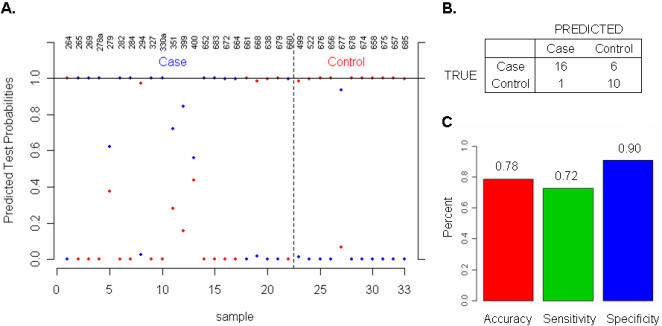
Validation of the 41-gene classification model using microarray analysis on an independent set of testing samples.(A). Classification probabilities for each testing sample: TAA (case) vs. normal (control); (B). Contingency table summarizes the predicted and actual class membership for the testing set; (C). Classification accuracy, sensitivity and specificity.